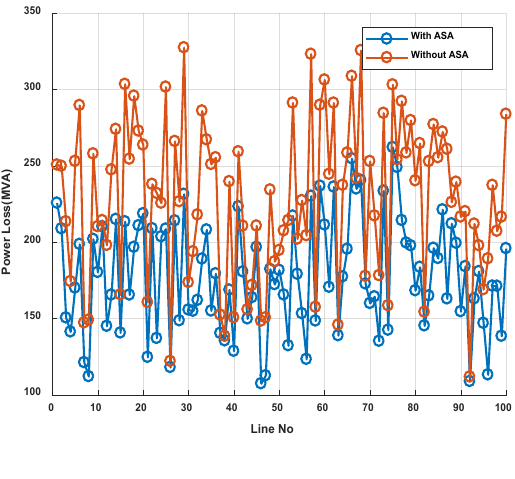
Figure 15. Analysis of Power loss